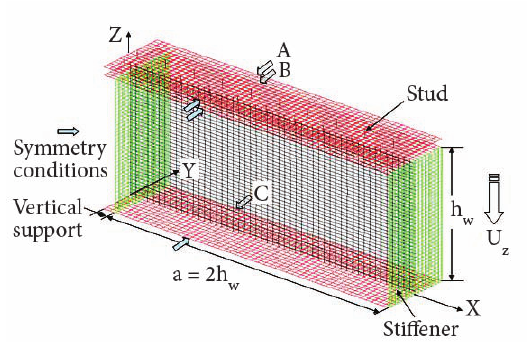
the addition of very stiff spring elements to the model has a negligible influence on the mechanical behaviour and the studs appear working exclusively in shear. The model is loaded by applying a displacement at its end to avoid possible geometrical element distortion. The vertical dis- placement U equal to 200 mm is applied in 10 steps. The z curves (M - θ) are plotted for different cross-sections of class 3 (Fig. 11) and of class 4 (Fig. 12). The rotation capac- ity of the cross-section is similar for all the cross-sections. The max point of each curve represents the beginning of the local buckling (M , θ ). After this point, a hyperbolic v v decreasing model (Eq (6)) could be adopted with appro- priate values for M , M and θ (M represents a horizon- 0 v v 0 tal asymptotic line). The web thickness has a stronger in- fluence on these curves than the bottom flange one (on the initial stiffness and also on the max hogging moment). The decreasing curves after buckling is similar with nearly the same value of buckling rotation (θ ≈ 0.014 rad). The curve v related to Eq (6) plotted for H1 as an example, gives a good prediction for the behaviour after buckling. The buckling rotation is also nearly the same in the case of cross-section of class 4 (θ ≈ 0.012 v